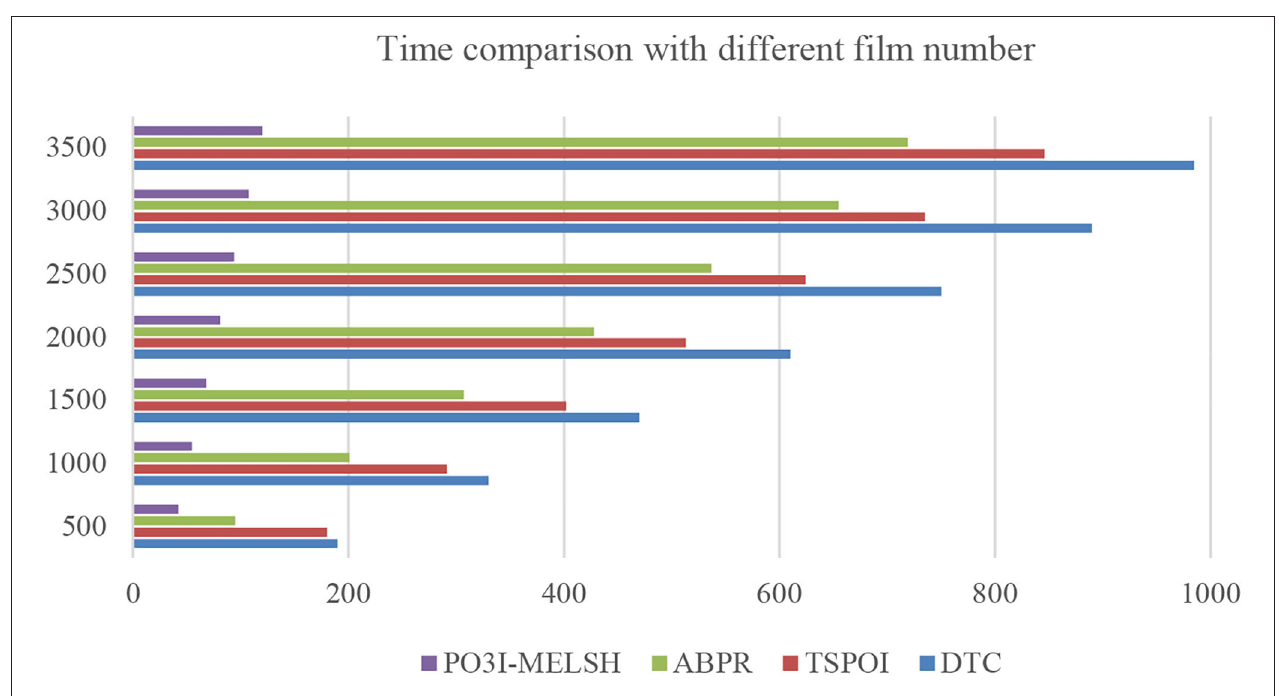
FIGURE 5 | Effect of film number on